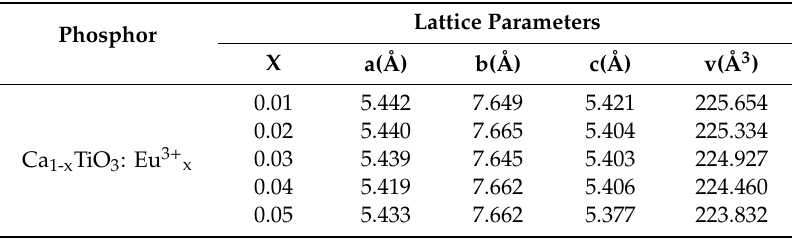
Table 1. Lattice parameters of Ca 1-x TiO 3 :Eu 3 + x phosphors doped with various concentrations of Eu 3 + .